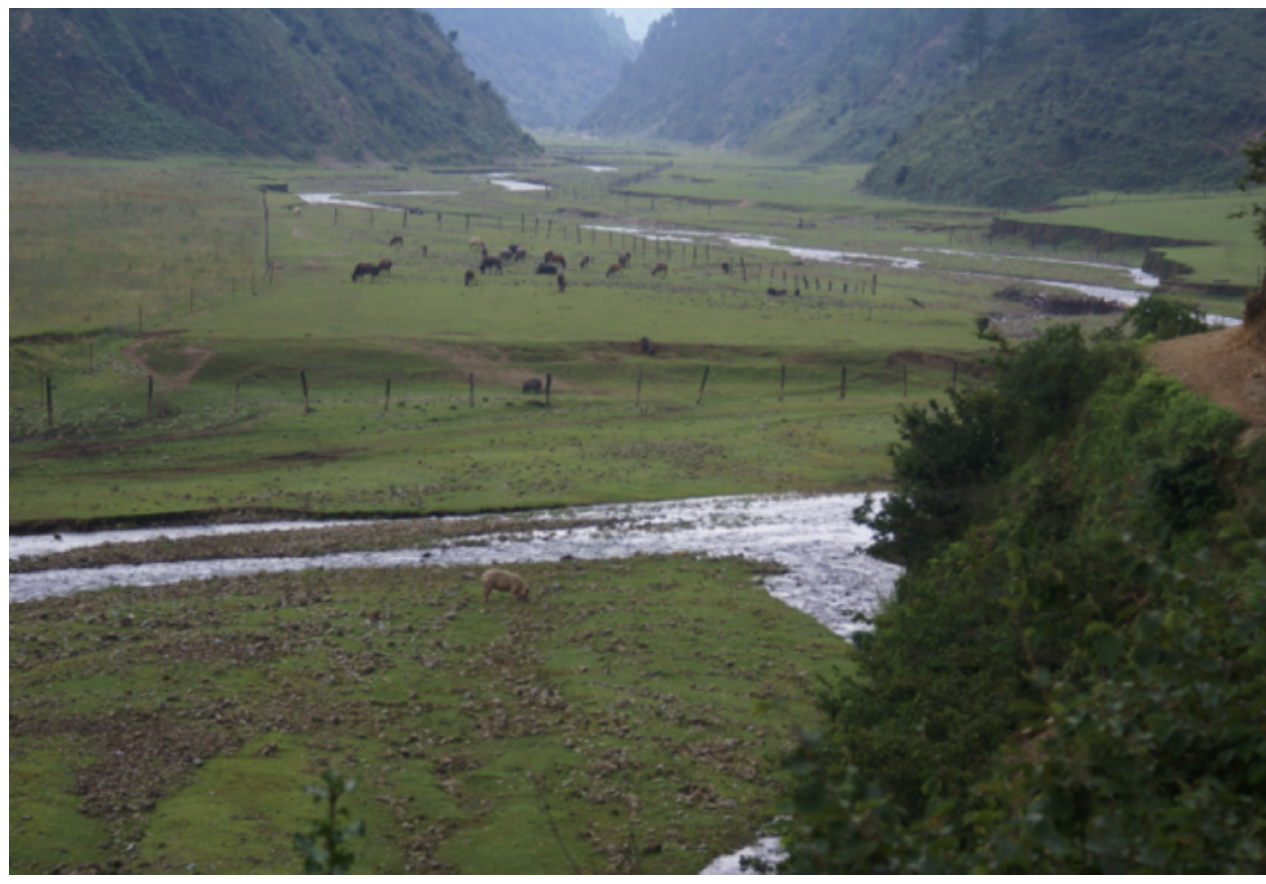
Fig. 6. Valley floor of part of the Apiladda watershed in 2008, showing the braided stream course, eroded stream terraces, lack of trees, presences of grazing animals, and newly installed fencing to protect a poplar